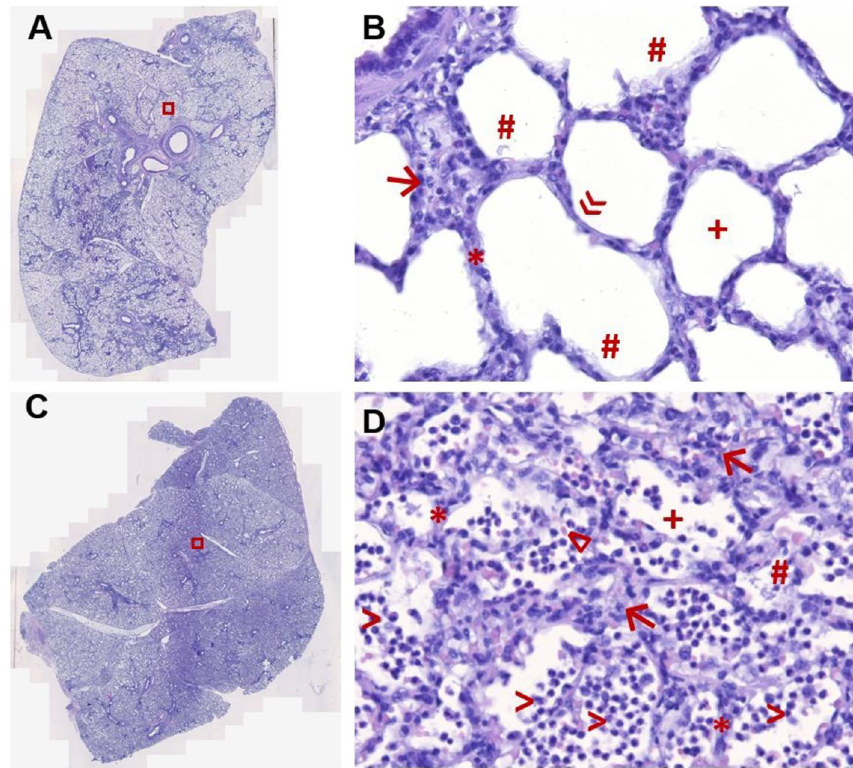
Fig. 6 Histopathology. Representative tissue sections stained with hematoxylin/eosin of the right lower lung lobe of pigs after lavage-induced surfactant depletion and subsequent protective A , B or injurious C , D mechanical ventilation. High magnification fields ( B , D , 400) correspond to red box on low magnification × field ( A , C , 100). Note the condensed histoarchitecture and signs of diffuse alveolar damage present × after lavage and injurious ventilation ( C , D ), including septal thickening (*), massive interstitial ( ) and → intra-alveolar ( >) infiltration of neutrophils, intra-alveolar erythrocytes (∆), protein strands (#), and disruption of the alveolar integrity ( ). In contrast, more aerated surface area with preserved alveolar architecture ( ), + + identification of type I pneumocytes (»), and less alveolar damage is present after lavage and protective ventilation ( A , B ). Septal thickening, neutrophil infiltration, and intra-alveolar protein strands occurred to a much lower